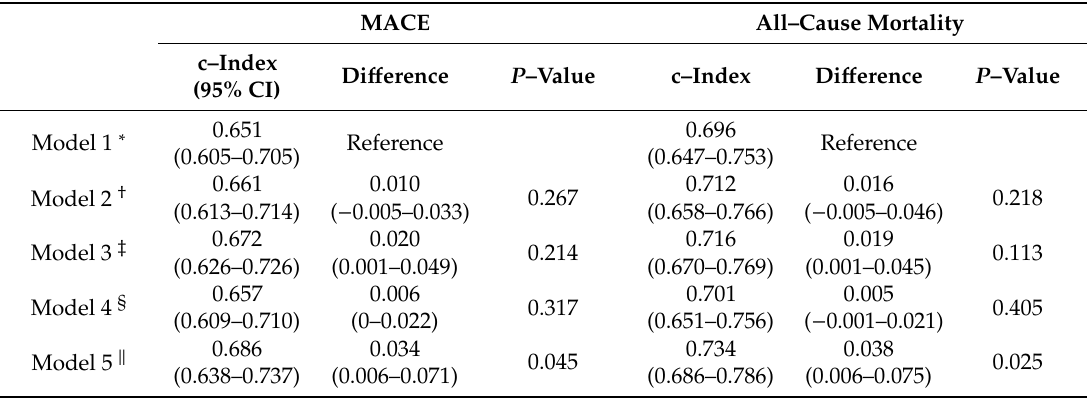
Table 3. C-indices of Heagerty’s incident / dynamic AUC for predicting MACE and all-cause